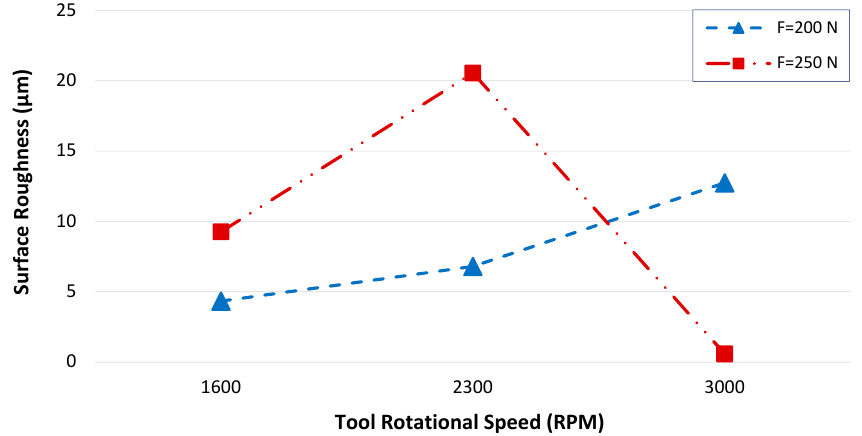
Figure 10. The surface roughness ( Ra ) values of experimental samples provided by process parameters close to the roughest sample.